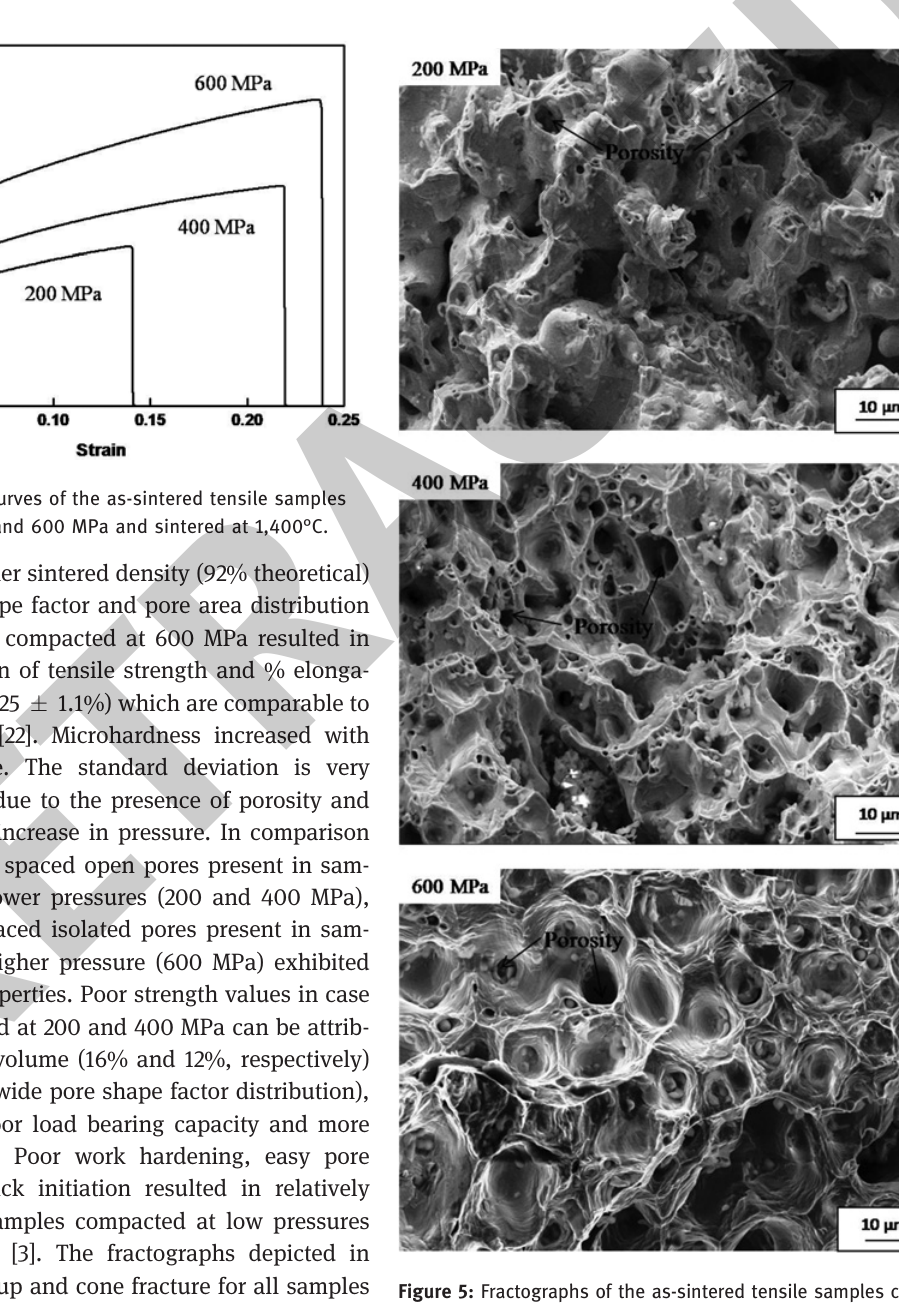
Figure 5: Fractographs of the as-sintered tensile samples compacted at various pressures (200, 400 and 600 MPa) and sintered at